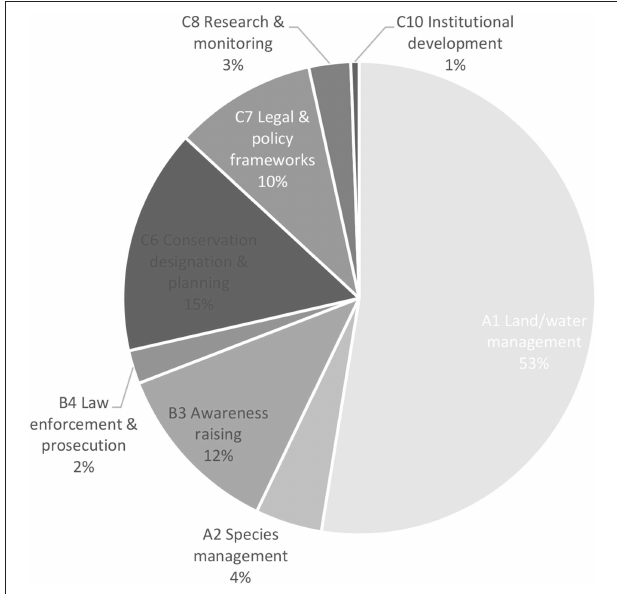
FIGURE 9 | The percentage distribution of the 133 recommended interventions (from 64 publications) classified according to the Conservation Measures Partnership (CMP; Conservation Actions Classification v 2.00 Framework Levels 1–2; Supplementary Material 3 ). Note that a single paper can employ several